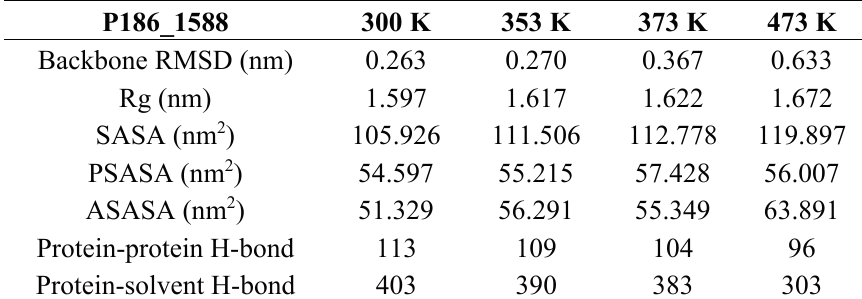
Table 4. Average of Rg, SASA and average number of protein-protein and protein-solvent H-bonds in P186_1588 at different temperature